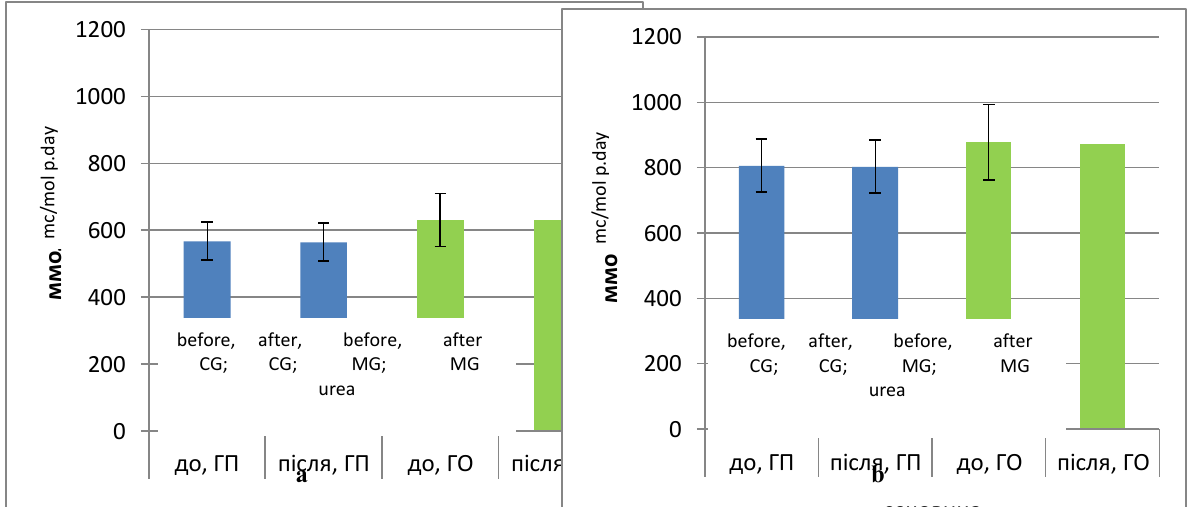
Fig.4. Indicators of bio-chemical monitoring by excretion of urea before and after experiment in lactate cluster (of main and comparative groups): a) by bicycle stress test «Vita maxima»; b) by results of control special tests. (р ≥ 0.05). CG – comparative group, MG – main